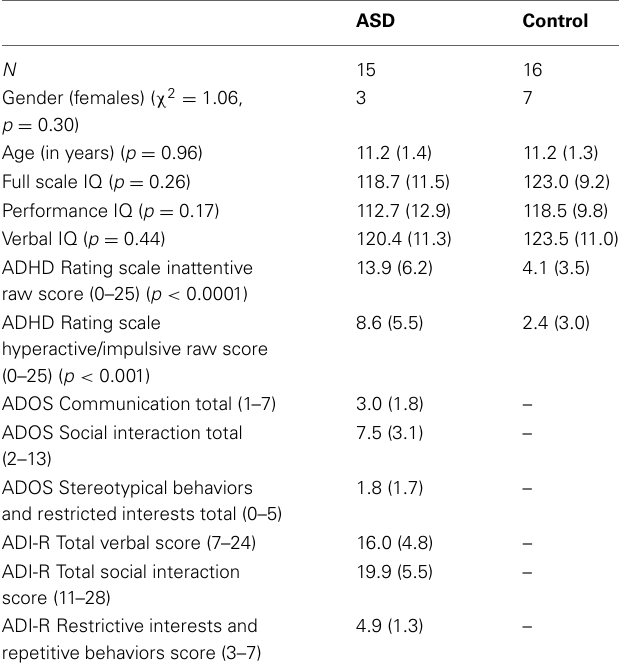
Table 1 | Demographic characteristics (Mean and standard deviation in